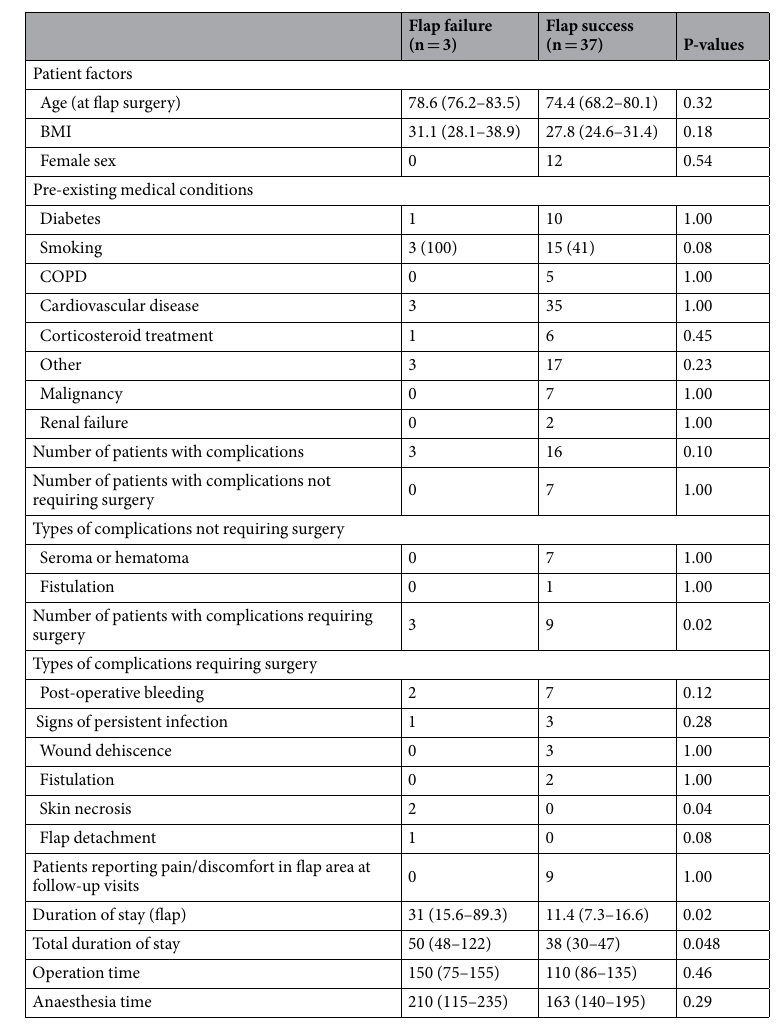
Table 2. The difference between the patients grouped by flap outcome. Data are presented as median (25–75 centile) or